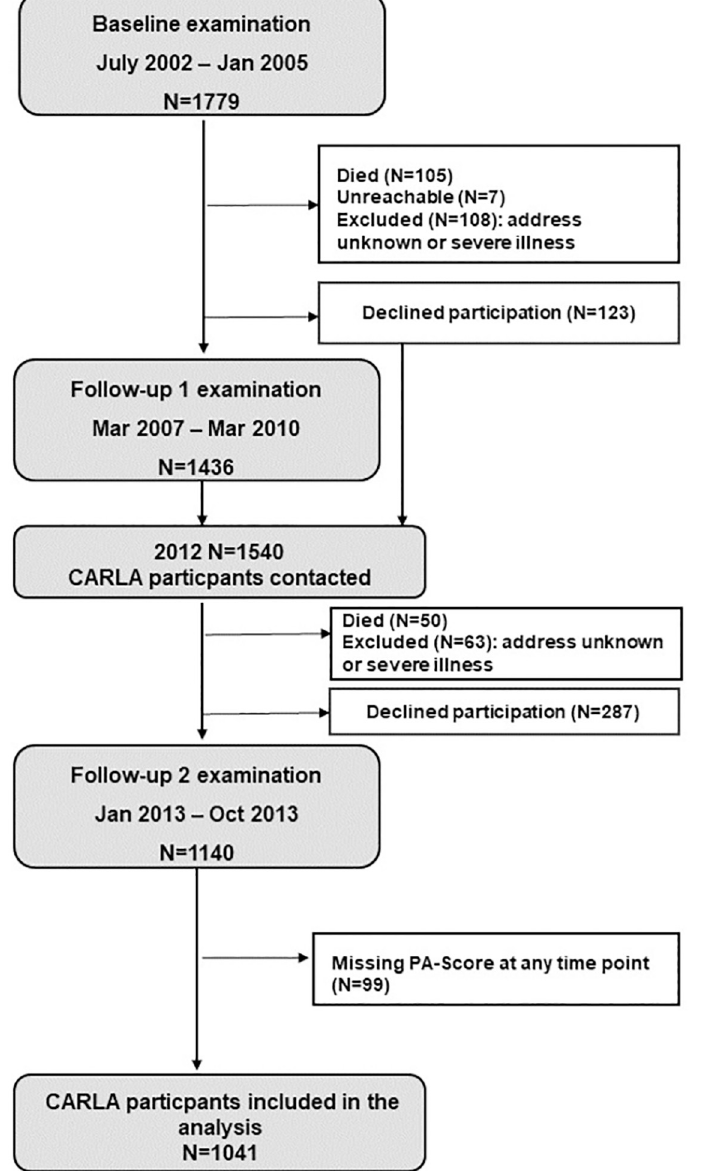
Fig 1. Flowchart of the 1041 CARLA participants included in the